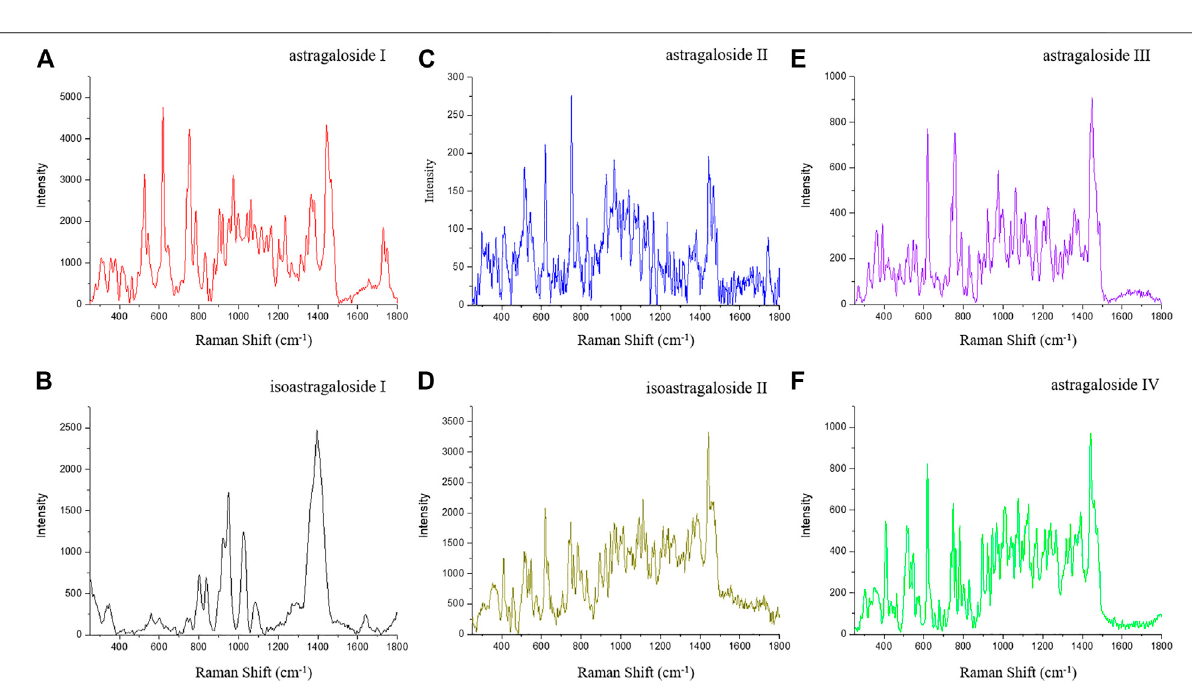
Frontiers in Pharmacology |